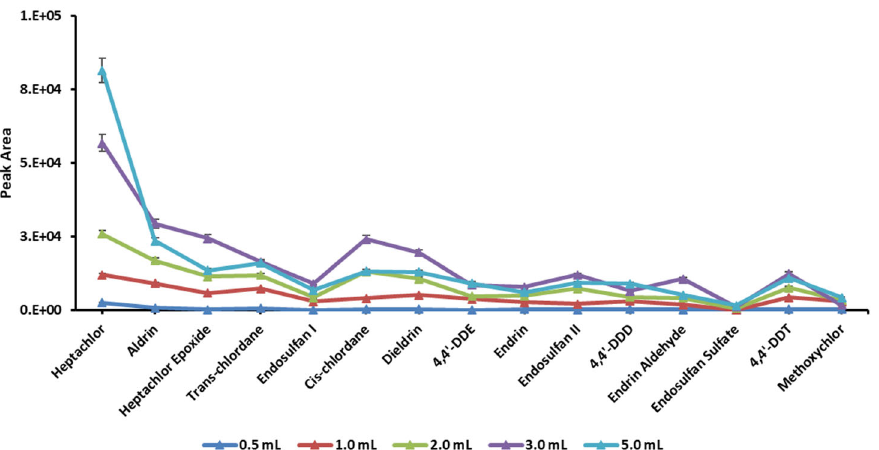
Figure 3. Optimization of extraction solvent